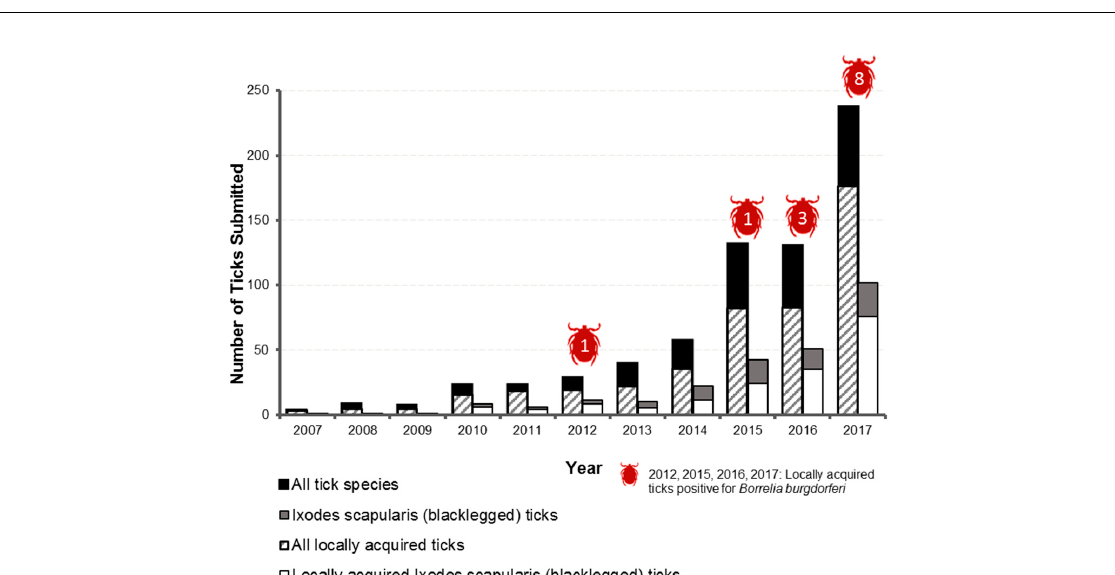
Figure 3. Ticks submitted to the Simcoe Muskoka District Health Unit and locally acquired ticks positive for Lyme disease, 2007–2017. Data Sources: Passive tick surveillance spreadsheet, extracted 8 May 2018. Interpretive note (1): Changes in tick submission rates are not necessarily indicative of an increase in local tick populations, and may be a result of other factors such as heightened public awareness. Interpretive note (2): Submitted ticks may originate from any location that the submitter has traveled in recent days, and not necessarily from within Simcoe Muskoka. It is estimated that two thirds of ticks submitted are acquired in Simcoe